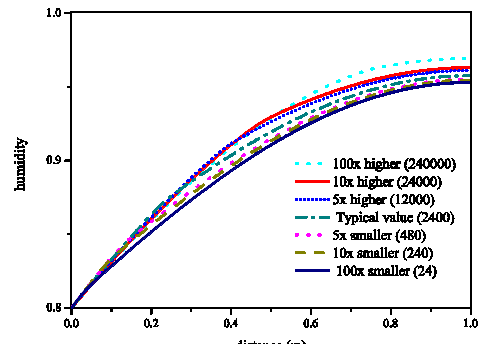
Figure 5. Parametric analyses, results for humidity field - Initial CO 2 diffusivity (values in mm 2 /day) - 50 years - Given the symmetry, in this figure only half of the profile is presented